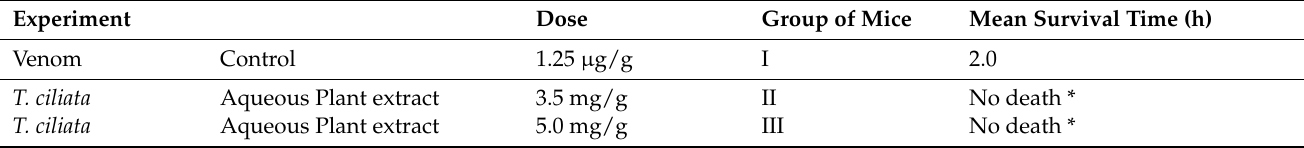
Table 3. Complete neutralization of N. melanoleuca venom by aqueous extract of T. ciliata root bark. Experiment